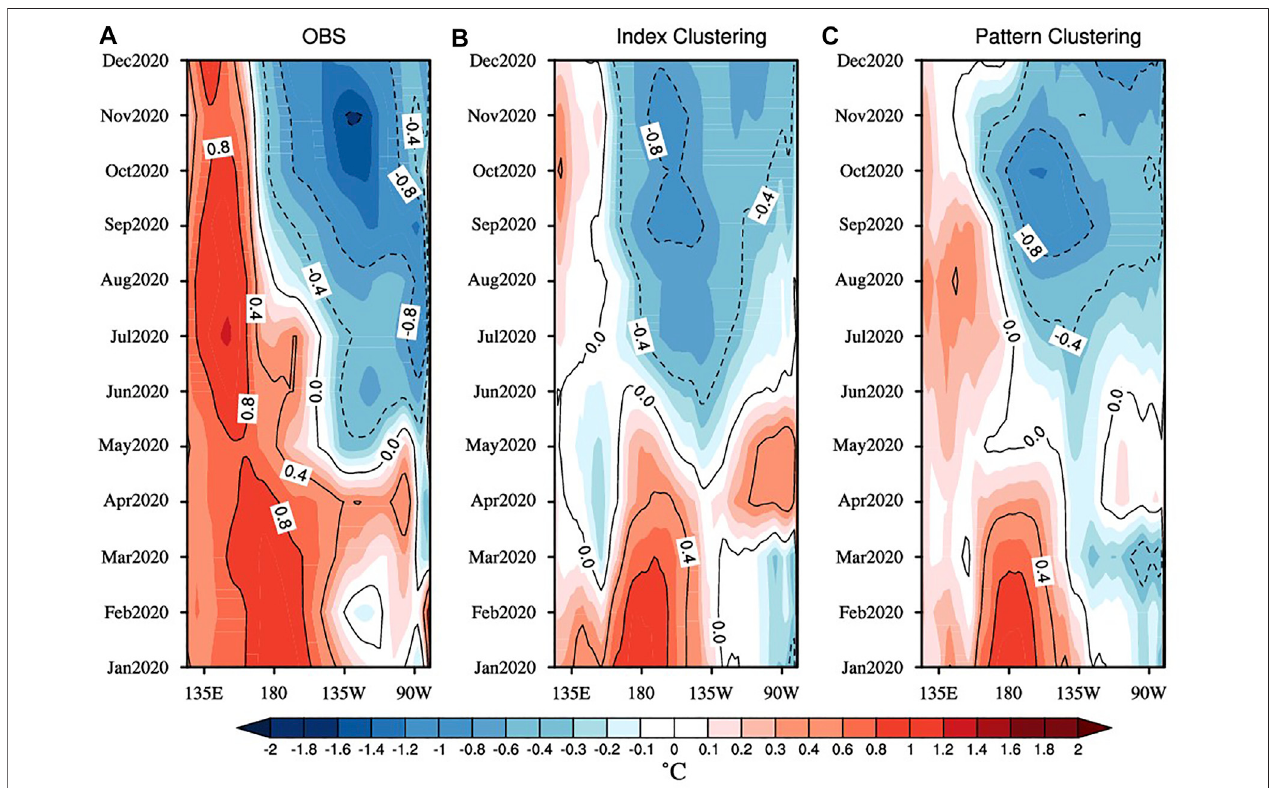
FIGURE2| TemporalevolutionoftheSSTAalongtheequatorialPaci fi c(averagedbetween5 ° Sand5 ° N)in2020for (A) observations, (B) theensemblemeanofthe best prediction members by index clustering, and (C) the ensemble mean of the best prediction members by pattern clustering. The contour interval is 0.4 ° C.